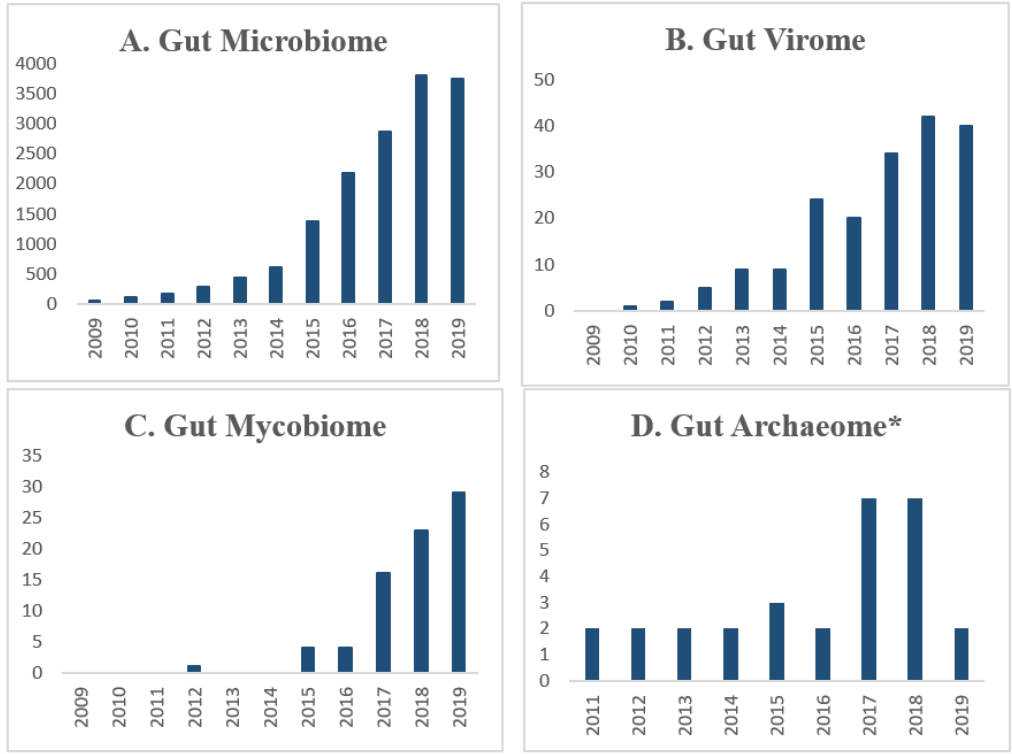
Figure 1. Scientific publications on various microbial communities of the gut microbiome. The number of peer-reviewed scientific publications for ( A ) microbiome, ( B ) virome ( C ) mycobiome and ( D ) archaeome studies. The list of peer-reviewed literature was collated in a non-systematic manner from the web of science (WOS) all database collection (MEDLINE, Inspec, Biological abstracts,